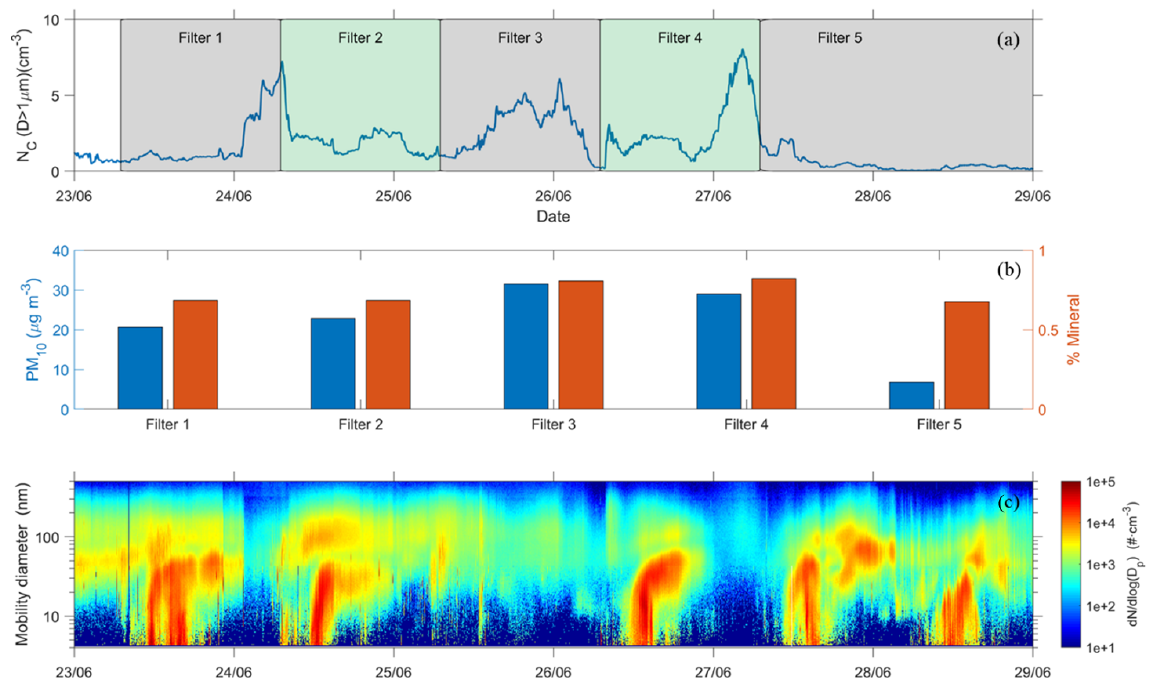
Figure 8. Temporal evolution of (a) coarse mode aerosol number concentration, (b) PM 10 concentration and mineral matter fraction (%), and (c) aerosol size distribution from 23 to 29 June at the SNS